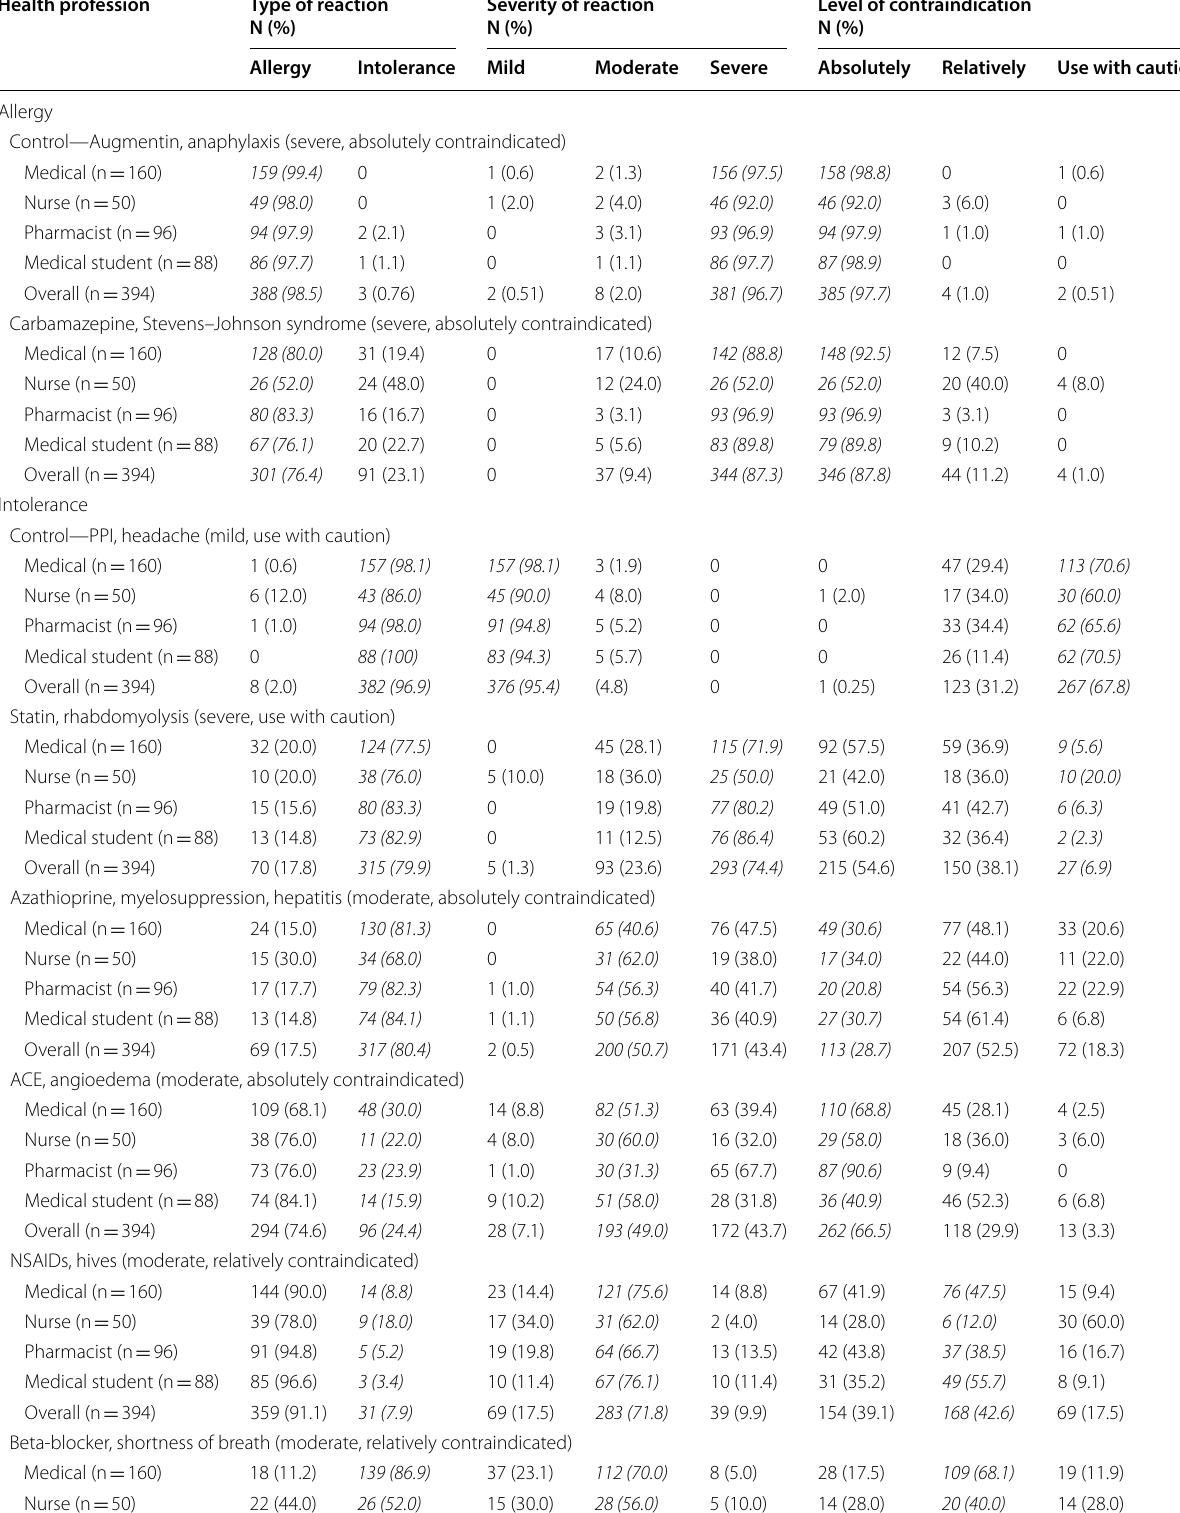
Table 1 Health professional assessment of clinical scenarios for type and severity of reaction and level contraindication Health